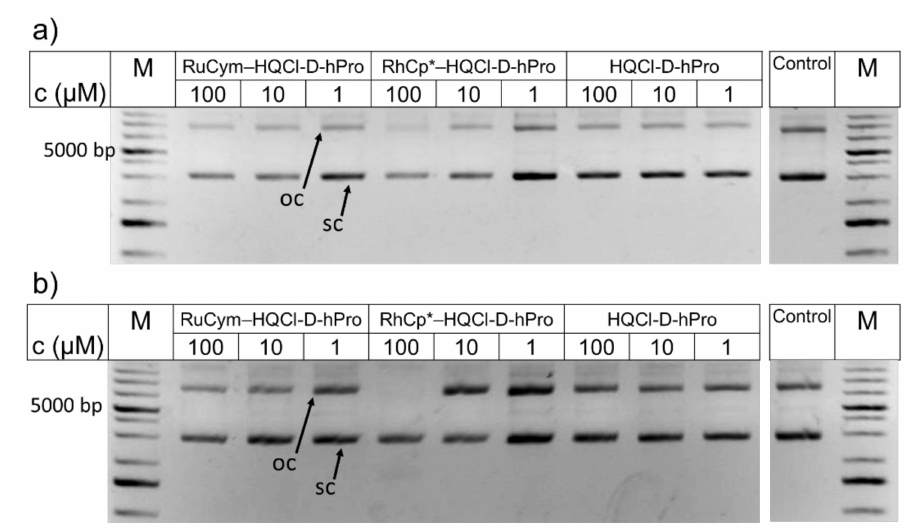
Figure 13. Incubation of HQCl-D-hPro ligand and its RuCym and RhCp* complexes with plasmid DNA for ( a ) 0 h, ( b ) 72 h analyzed on 1% ( w / v ) agarose gel. The reaction mixtures contained 50 ng pGEX-6P-1 plasmid DNA and HQCl-D-hPro, RuCym–HQCl-D-hPro, RhCp*–HQCl-D-hPro in concentrations between 0 and 100 µ M. {pH = 7.4 (20 mM phosphate buffer, 4 mM KCl); incubation time: up to 3 days; T = 37 ◦ C.} Arrows indicate various forms of the plasmid: oc: open circular, sc: supercoiled. Control sample contained only plasmid DNA. 1 kb GeneRuler Plus was used as a marker